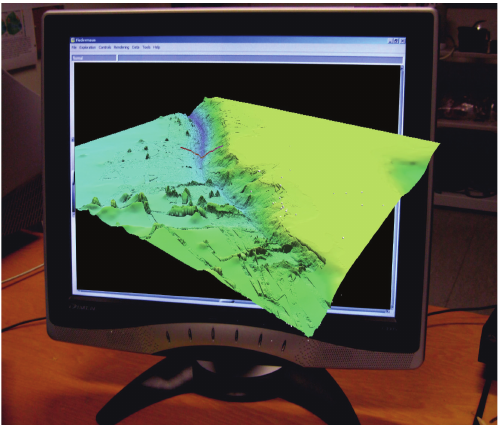
Figure 4: Autostereoscopic displays use optical elements in front or behind a standard liquid crystal display (LCD) to deliver a separate picture to each eye of the user without the need to wear glasses. The figure shows the bathymetric dataset of the Central American subduction zone, the deep trench, and the flat shelf area o ff shore Costa Rica. The screen shown is a Dimen C190S without eye tracking—the user must find and hold the correct viewing position in front of the screen.